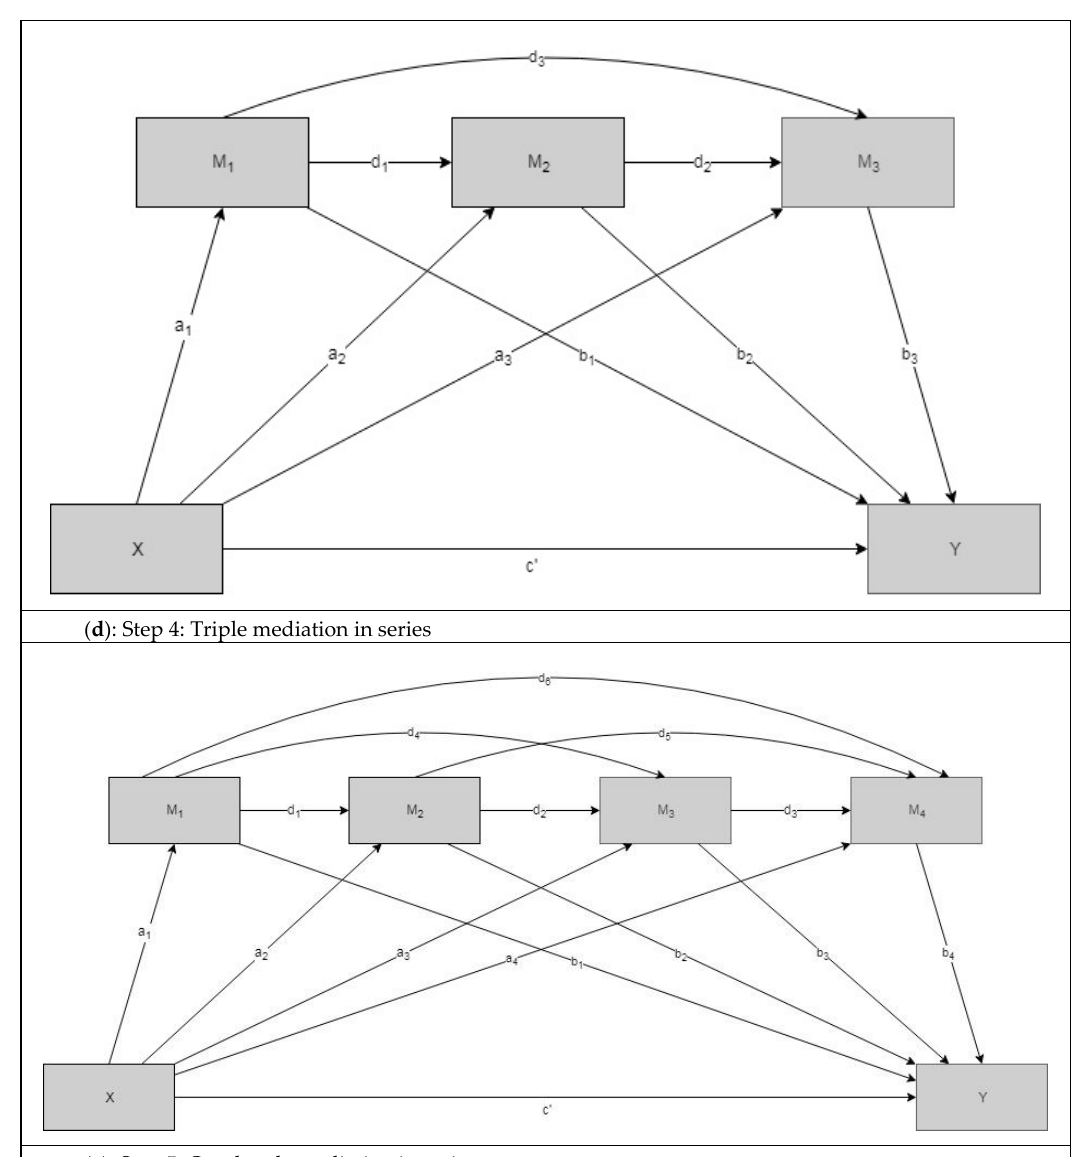
Figure A2. Di ff erent mediation steps testing the relationships of the